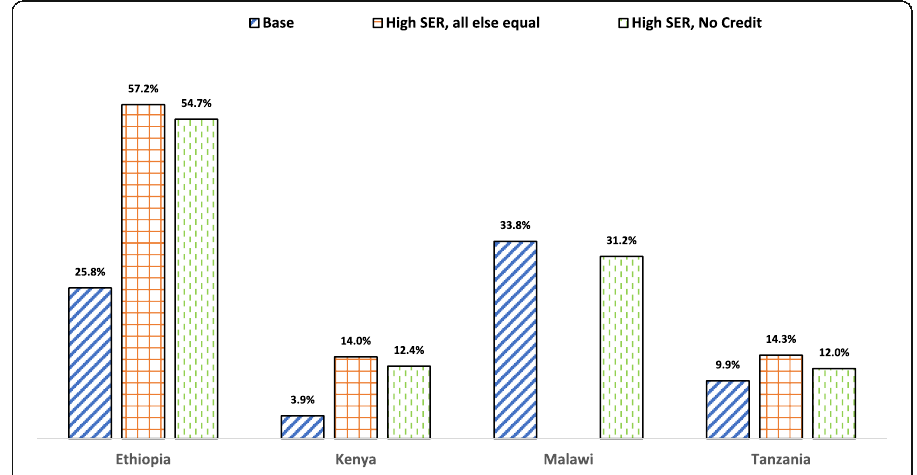
Fig. 3 Simulations involving subsidy expenditures as a percentage of agricultural budgets in Ethiopia, Kenya, Malawi and